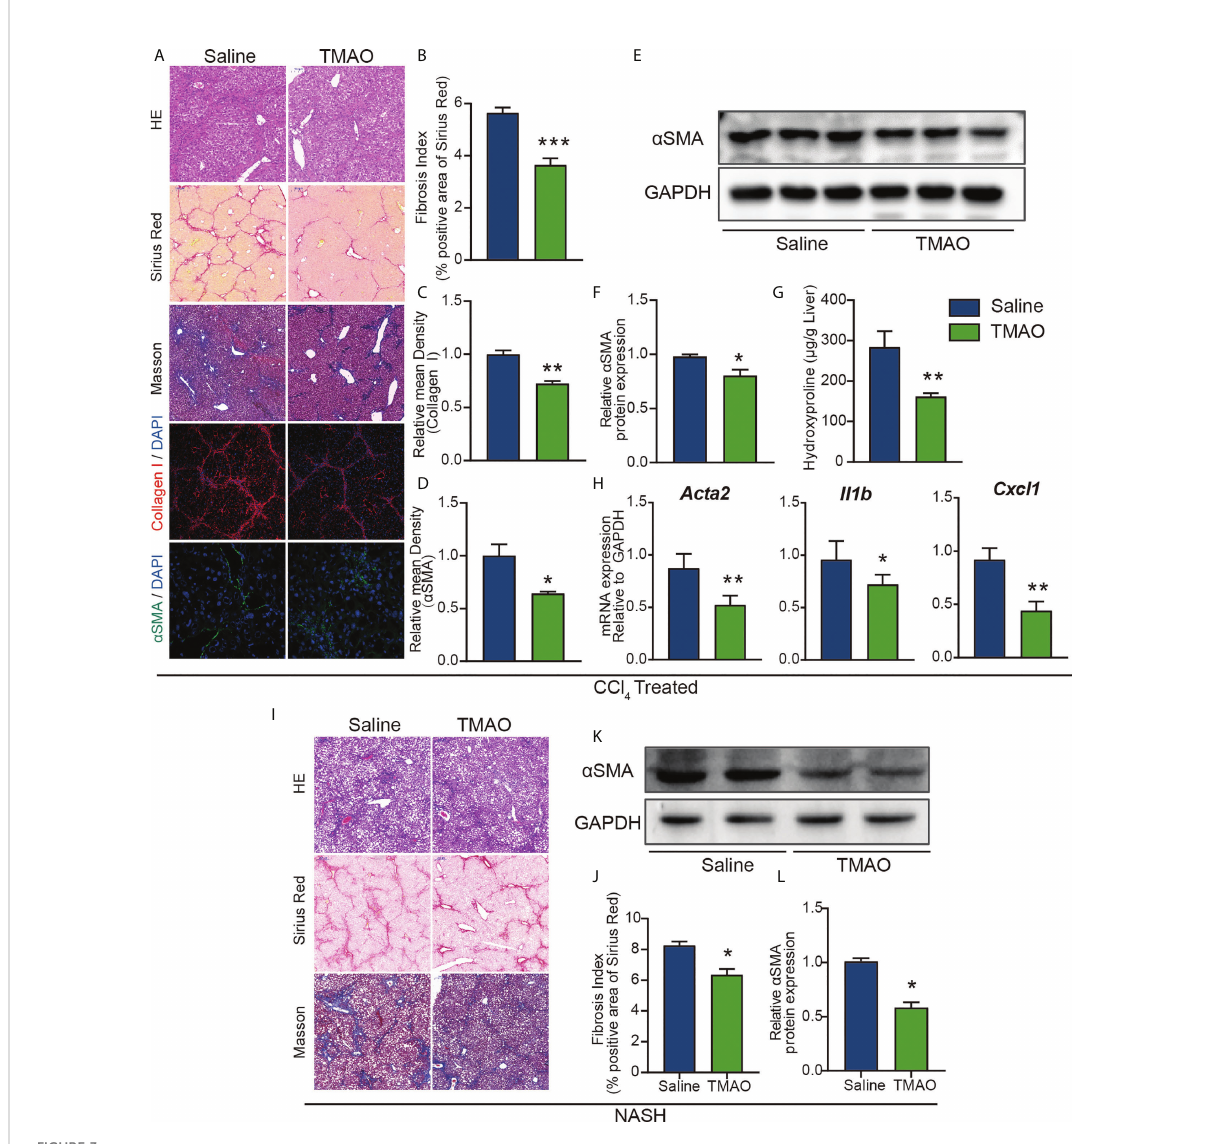
FIGURE 3 TMAO alleviates liver fi brosis in murine liver fi brosis and NASH models (A – F) Wild-type mice were injected with CCl 4 every two days 9 times and normal saline or TMAO (75mg/kg) injection on the remaining days. (n=8/group) Liver fi brosis was analyzed by H&E, Sirius red, Masson staining and IF for collagen I and a SMA (A – D) , WB for a SMA (E – F) , the content of hydroxyproline (G) , hepatic a SMA, CXCL1 and IL1 b were quanti fi ed by the RT – PCR assay (H) . (I – L) Mice were treated with WD/CCl 4 for up to 16 weeks and normal saline or TMAO (75mg/kg) injection on the remaining days. H&E, Masson and Sirius Red staining of representative mice treated with normal saline or TMAO (I – J) , WB for a SMA (K – L) . *p<0.05, **p<0.01,